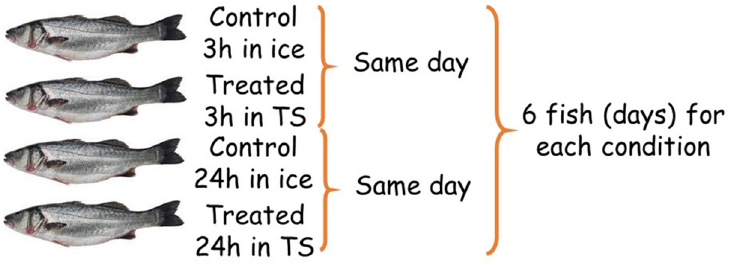
Figure 1. Study design adopted: paired comparisons were carried out. Two fish samples were analyzed each day: one treated and one control fish sample. analyzed each day: one treated and one control fish